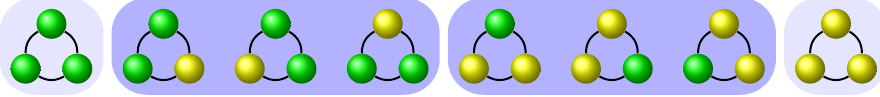
Fig. 5. Orbits of necklaces with 3 beads in 2 colours under cycle action by Z + 3 are shown as background round rectangles. Light blue orbits of monocoloured ones always have size = 1 . Dark blue orbits of multicoloured ones always have size > 1 . By Orbit-Stabilizer theorem, orbit size divides | Z + 3 | = 3 , hence multicoloured orbit size = 3